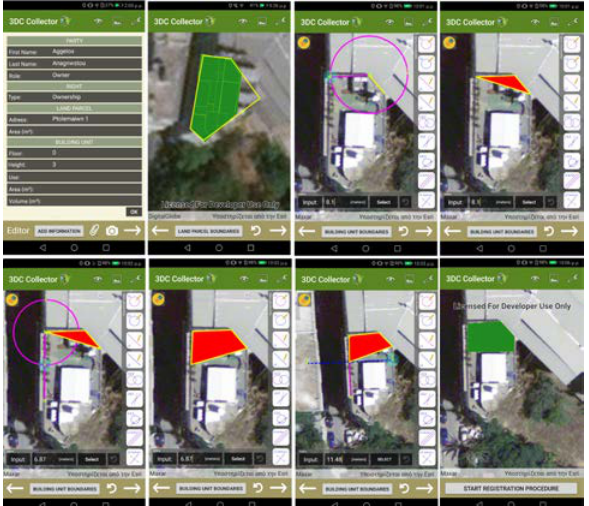
Figure 7. Example of the registration process through the developed mobile application, including (top left) the insertion of the adequate information, (middle top left) the polygon digitization describing the land parcel and (middle top right, top right and bottom) the registration procedure utilizing the geometric tools for the identification/digitization of the polygon describing the building unit, on the